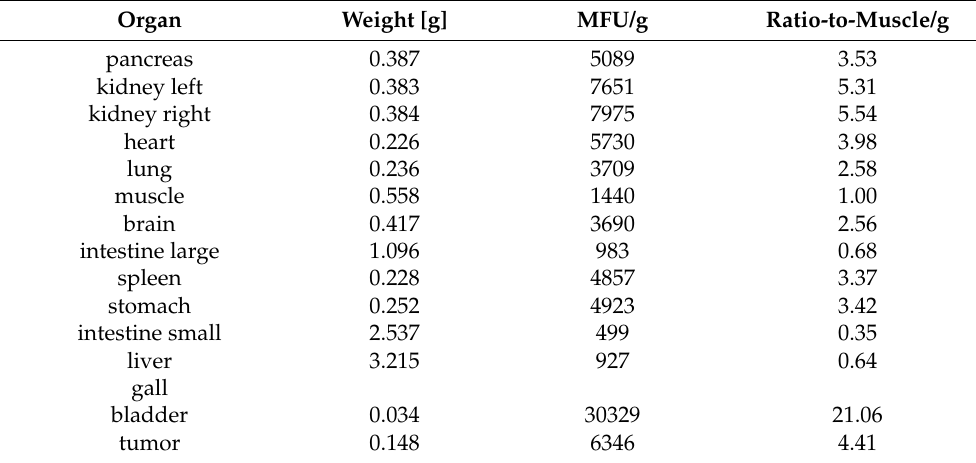
Figure A24. Ex vivo biodistribution of AuNP-RGD-NIR-dye 8 at A431-tumor-bearing mouse. Table A1. Biodistribution of AuNP-RGD-NIR-dye 8 in A431 tumor-bearing mice. MFU = Mean fluorescence units.